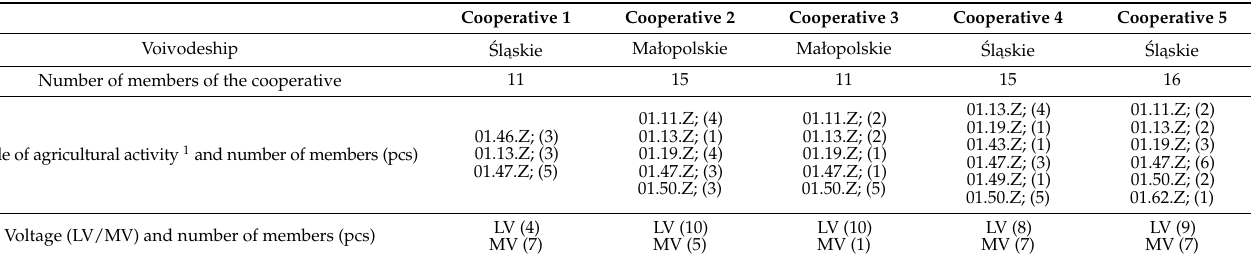
Table 1. Characteristics of each analytical